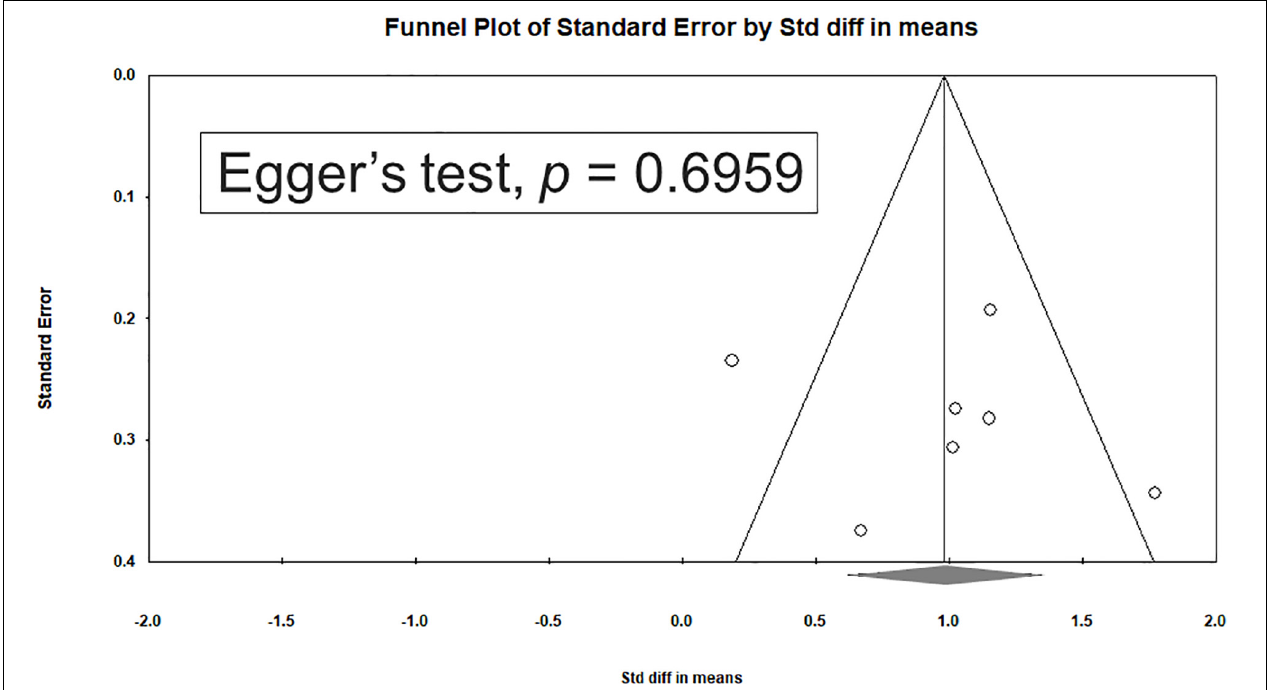
FIGURE 4 | Funnel plots for the standardized mean differences of